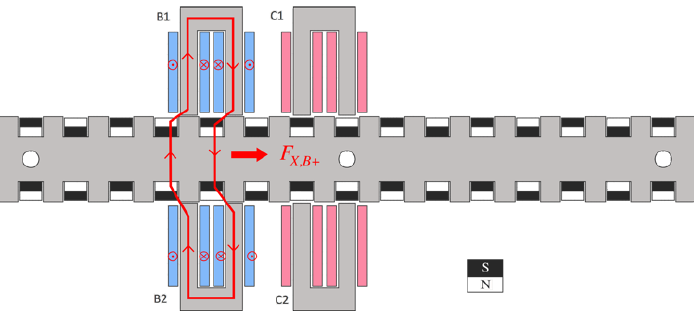
Figure 1. View of the proposed two-phase double-sided linear hybrid reluctance actuator (PM-LHRM) and operation principle when exciting phase B+ at x = 0 mm.